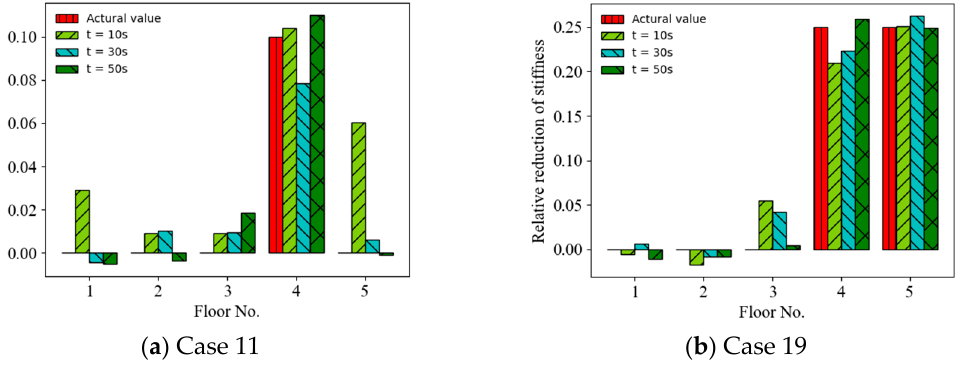
Figure 8. Mean prediction results of structural anomaly using acceleration responses with different time lengths as ANN input.